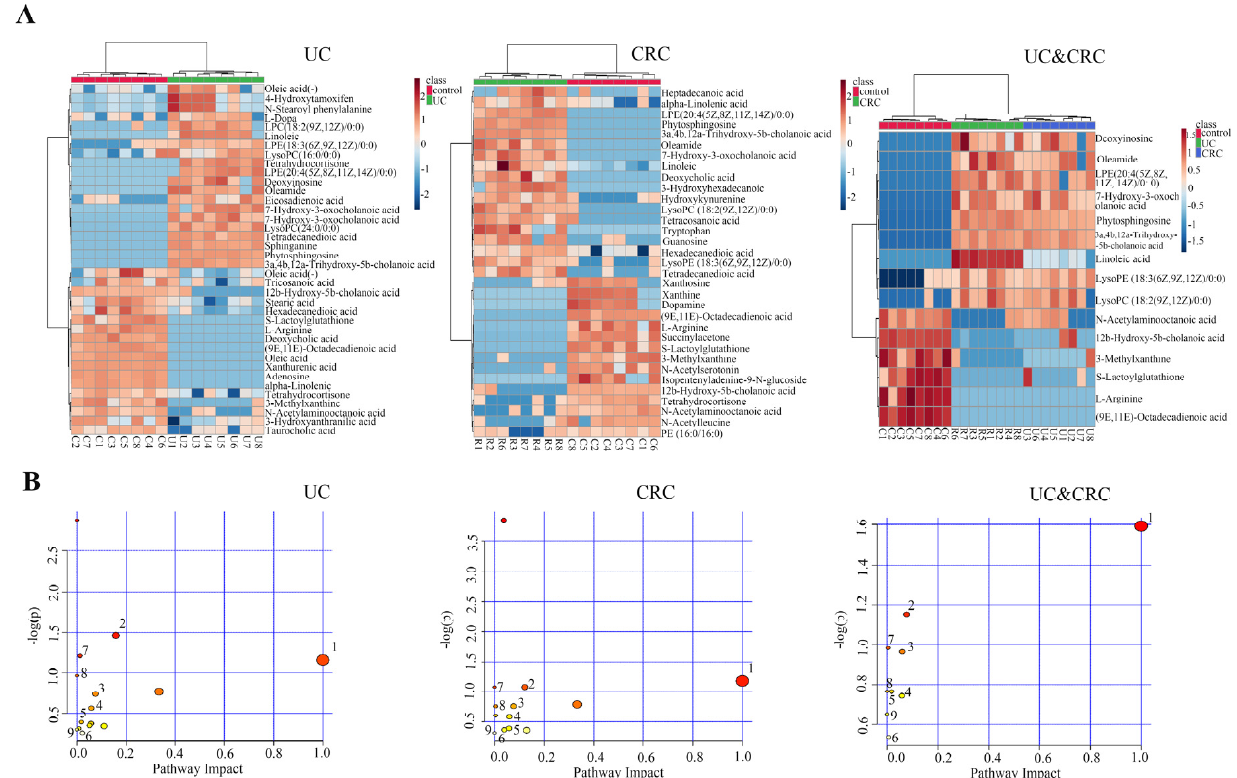
Figure 2. ( A ) The hierarchical clustering heatmap. ( B ) Pathway analysis overview showing altered metabolic pathways in the UC group: (1) linoleic acid metabolism, (2) sphingolipid metabolism, (3) purine metabolism, (4) biosynthesis of unsaturated fatty acids, (5) taurine and hypotaurine metabolism, (6) alpha-linolenic acid metabolism, (7) arginine biosynthesis, (8) pyruvate metabolism, (9) glycerophospholipid metabolism, (10) arginine and proline metabolism, (11) tryptophan metabolism, (12) tyrosine metabolism, (13) primary bile acid biosynthesis, (14) aminoacv-tRNA biosvnthesis, (15) drug metabolism—cytochrome P450. In the CRC group: (1) linoleic acid metabolism, (2) purine metabolism, (3) biosynthesis of unsaturated fatty acids, (4) glycerophospholipid metabolism, (5) alpha-linolenic acid metabolism, (6) glycosylphosphatidylinositol (GPI)-anchor biosynthesis, (7) arginine biosynthesis, (8) sphingolipid metabolism, (9) pyruvate metabolism, (10) arginine and proline metabolism, (11) tryptophan metabolism, (12) tyrosine metabolism, (13) aminoacyl-tRNA biosynthesis. In the UC and CRC groups: (1) linoleic acid metabolism, (2) arginine biosynthesis, (3) sphingolipid metabolism, (4) pyruvate metabolism, (5) biosynthesis of unsaturated fatty acids, (6) glycerophospholipid metabolism, (7) arginine and proline metabolism, (8) aminoacyl-tRNA biosynthesis, (9) purine metabolism.